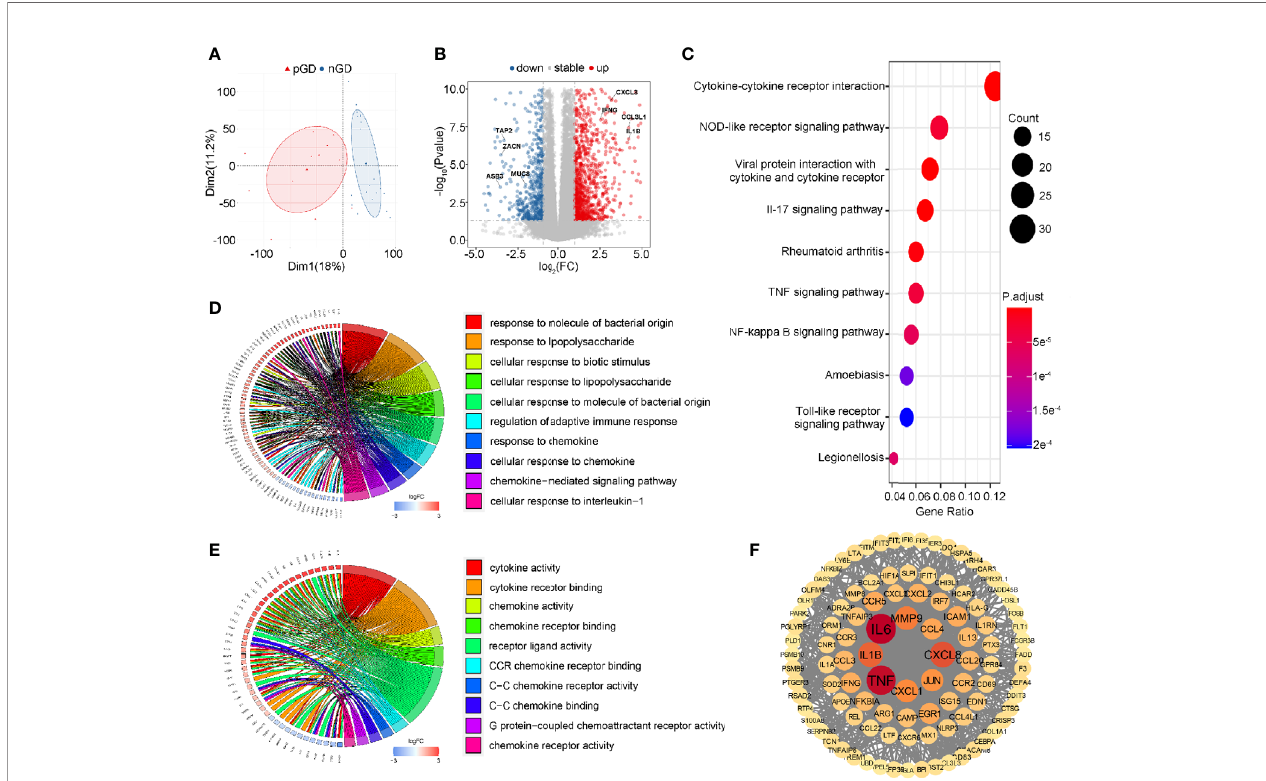
FIGURE 3 | Transcriptional pro fi ling of PBMCs in pGD and nGD patients. (A) PCA plot showed obvious differences with all expressed genes in pGD and nGD group. Red triangle represented pGD and blue circle for nGD. (B) Volcano plot showed DEGs between pGD and nGD group. Blue dots represented downregulated genes (N = 375) and red dots were upregulated genes (N = 696). The texts denoted in the plot were names for corresponding genes. (C) The top 10 most signi fi cant KEGG pathways for all DEGs. Size of bubble represented counts of the DEGs in corresponding pathway and color of bubble meant adjust p value. (D, E) GO enrichment analysis of DEGs among (D) biological processes and (E) molecular functions. Circos plots showed the relationship between genes and GO terms. The top 10 most signi fi cant GO processes were shown inthe plot retrospectively. (F) PPI network of potential key DEGs (degree ≧ 13).Sizeand color of each gene representedthe its degree score. pGD,persistentGraves ’ disease; nGD,newly diagnosed Graves ’ disease; PCA, principal component analysis; DEGs, differentially expressed genes; KEGG,Kyoto Encyclopedia of Genes andGenomes; GO, Gene ontology;PPI, Protein-protein